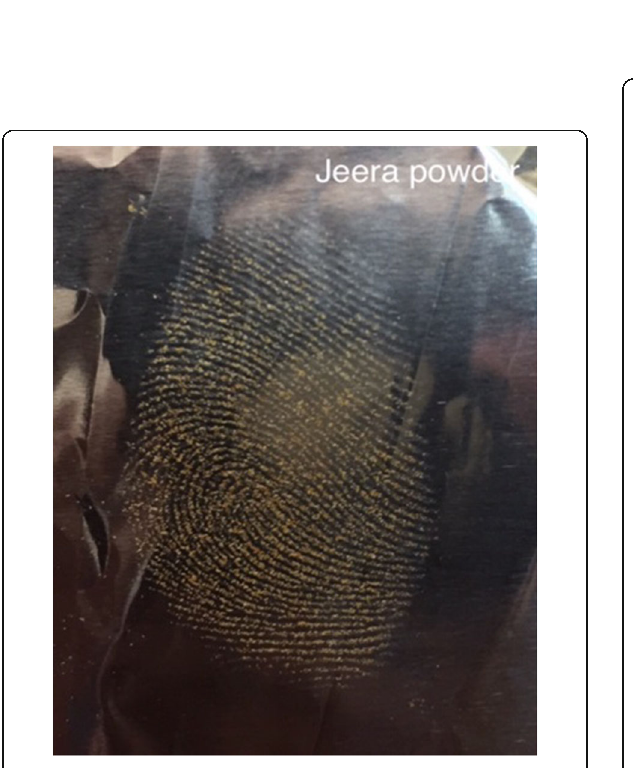
Fig. 12 Development of Latent fingerprint by Cumin powder on Aluminum Foil